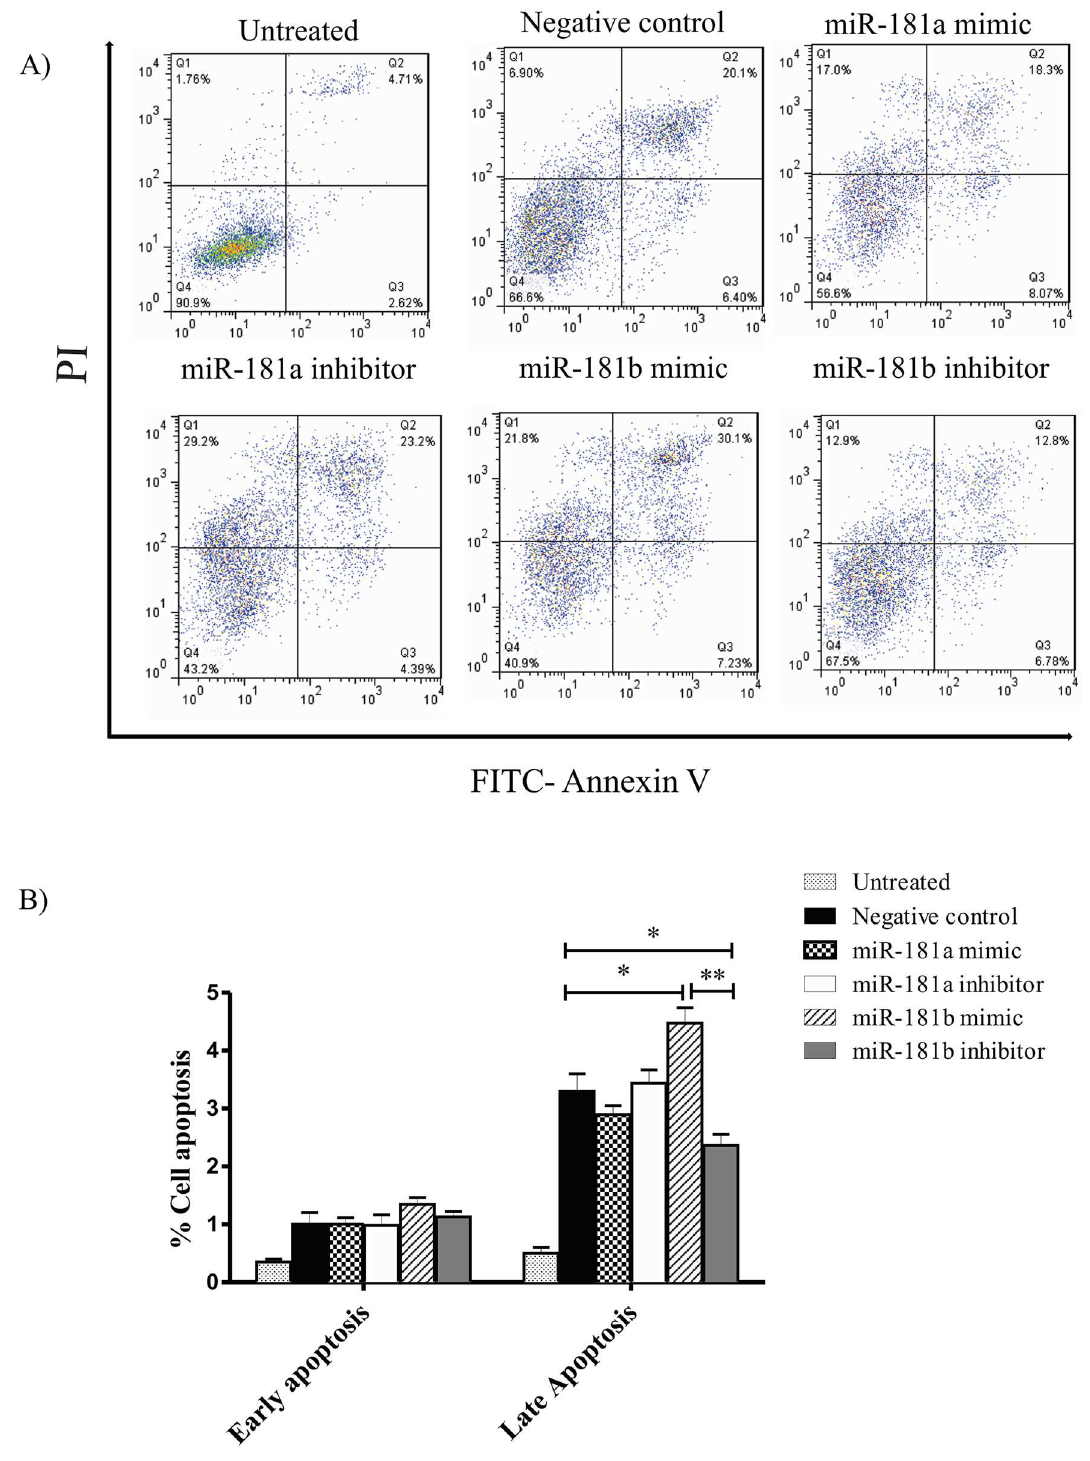
Fig 5. miR-181b increasesTNF- α -induced apoptosis. Cultured L929cells transfected with miR-181aand miR-181b mimics, inhibitorsor negativecontrol sequences(50nM) were treated with TNF- α (50 ng/mL) for 12 h. A) Representative flow cytometry graphs after doublestaining with AnnexinV-FITC and propidiumiodide. B) Percentageof apoptotic cells (Early apoptosis:Annexin + , Late apoptosis:Annexin + PI + ). Data are normalized to negativecontrol of early apoptosisshown as means + S E M (n = 5). ANOVA, tukey post hoc * p < 0.05,relative to negativecontrol.